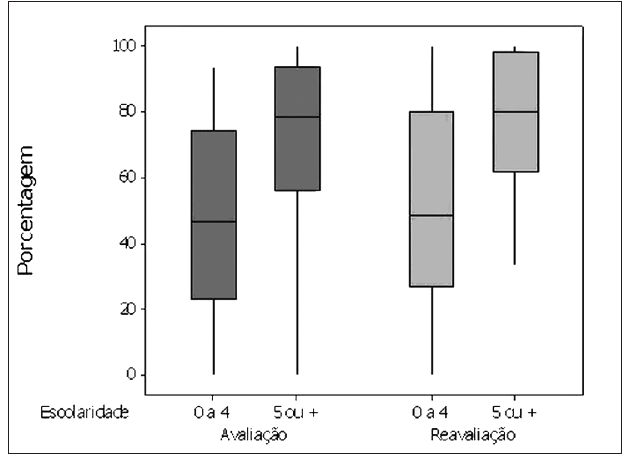
Figura 2. Distribuição dos indivíduos segundo com a porcentagem de acertos no TPD nas duas avaliações de acordo com a escolaridade. TPD: teste padrão de